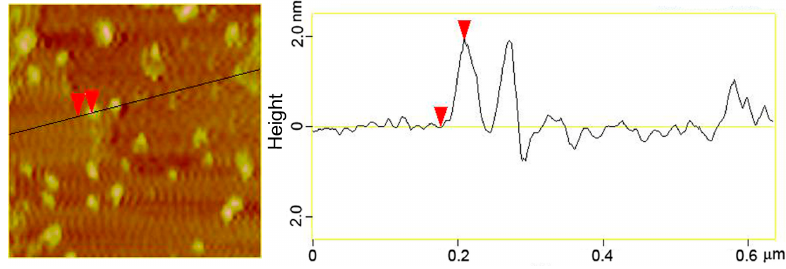
Figure 2. AFM image and the corresponding height measurement of the as-prepared AuNCs.